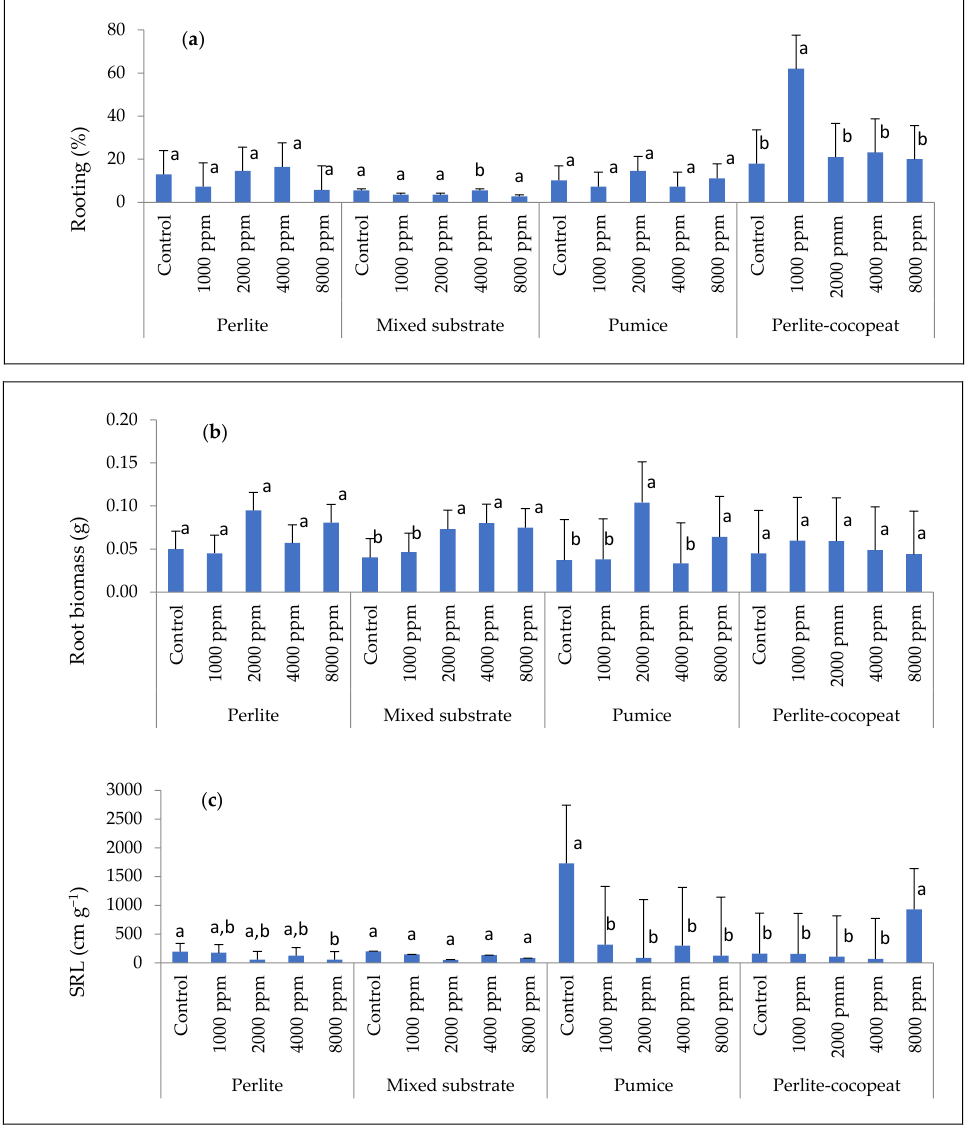
Figure 4. Mean values of rooting performance in rooted cuttings within substrates and with five IBA pretreatments: ( a ) % of rooting, ( b ) root biomass, and ( c ) SRL. Mean values with the same letter do not differ at 0.05 level according to LSD test. Sample data = 540 stem cuttings in each substrate. Error bars: LSD intervals.